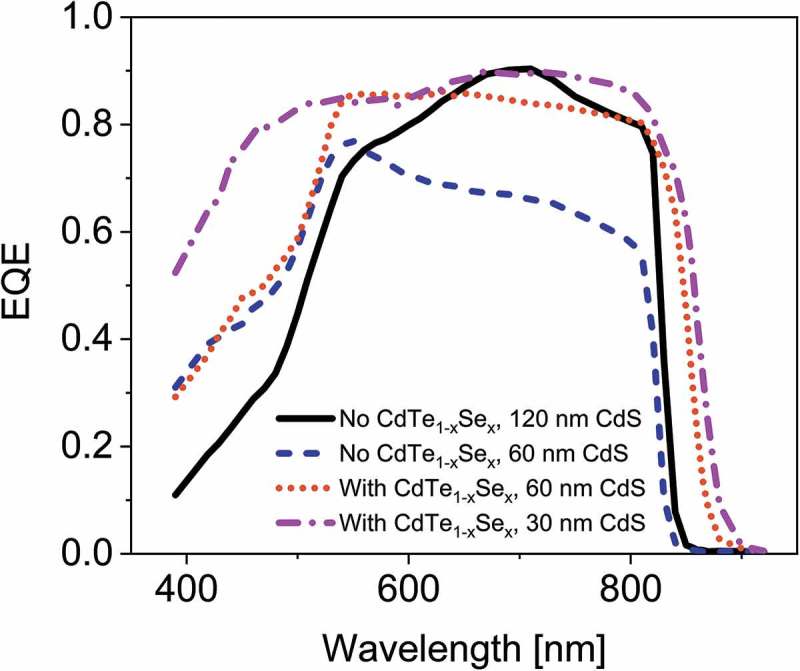
External quantum efficiency of CdTe solar cells with and without CdTe1-xSex grading of the absorber towards the CdS window layer, and with varying CdS window layer thicknesses.